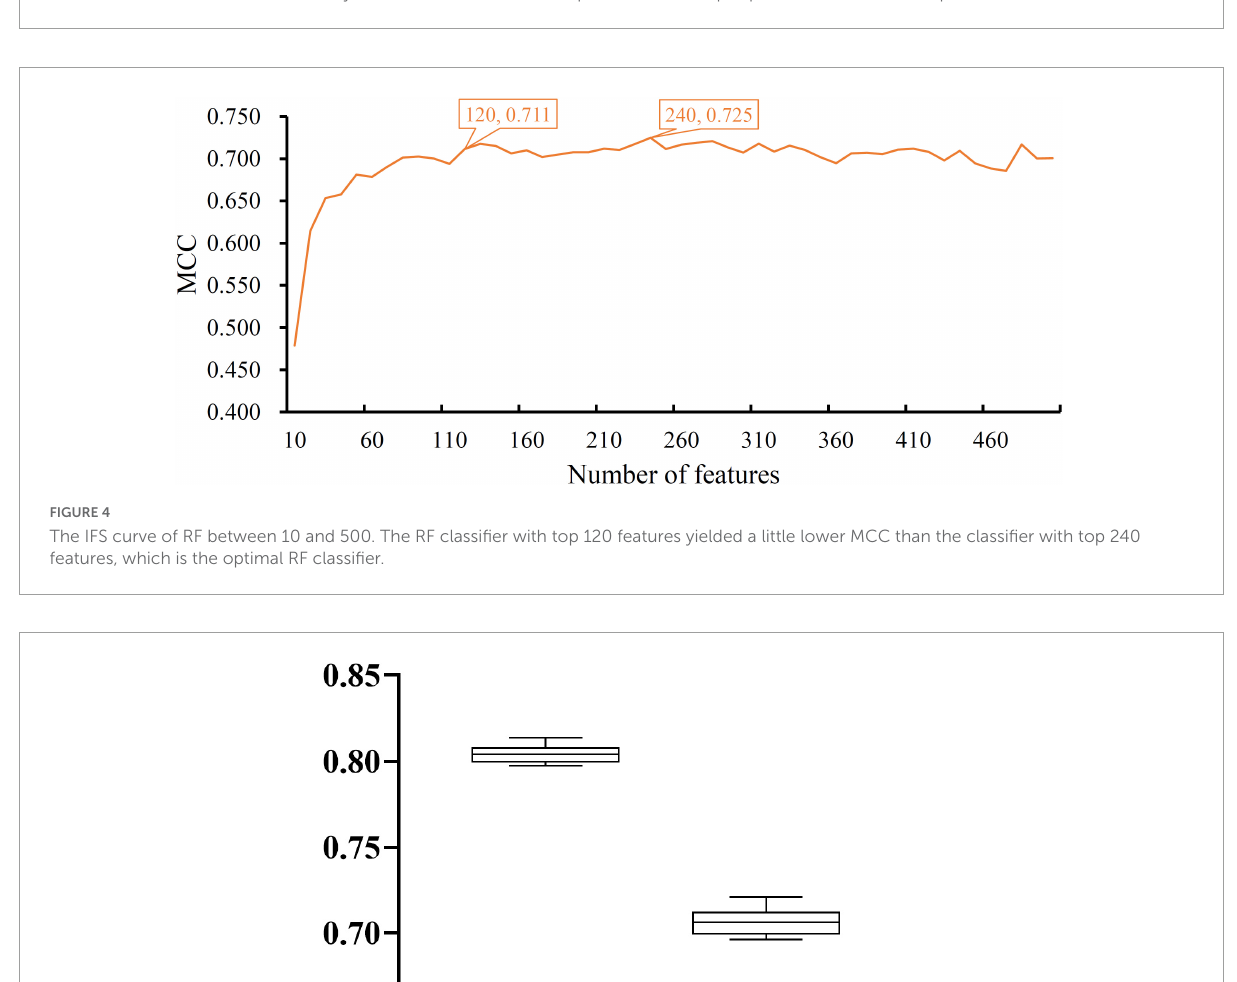
FIGURE3 The Individual accuracies of some key classifier. Two RF classifiers provide almost equal performance and are superior to the RIPPER classifier.